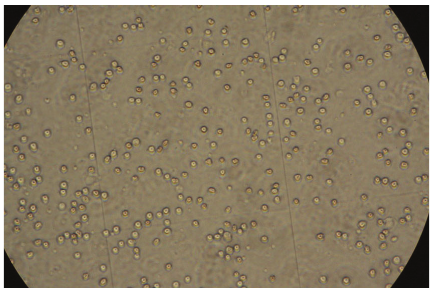
Figure 3: Nucleated cell counts. Monocytes were observed to be numerous, uniform in morphology, and with round cell bodies ( × 40).